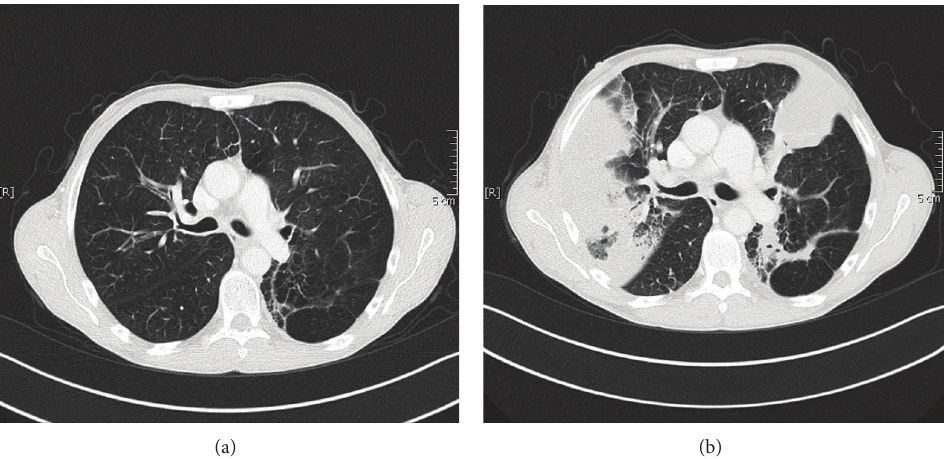
Figure 2: (a). CT scan 4 weeks before the intervention of endoscopic lung volume reduction revealed severe heterogeneous centrilobular lung emphysema with bilateral involvement of the upper lobes. (b) CT scan 3 days after the intervention of AeriSeal revealed the induced atelectasis of the bilateral upper